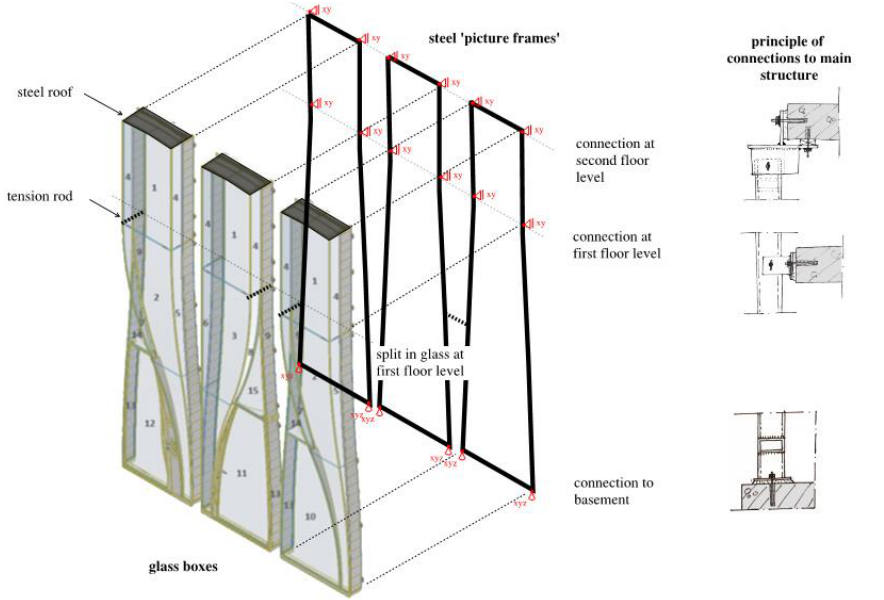
Fig. 3 Explanation of structural